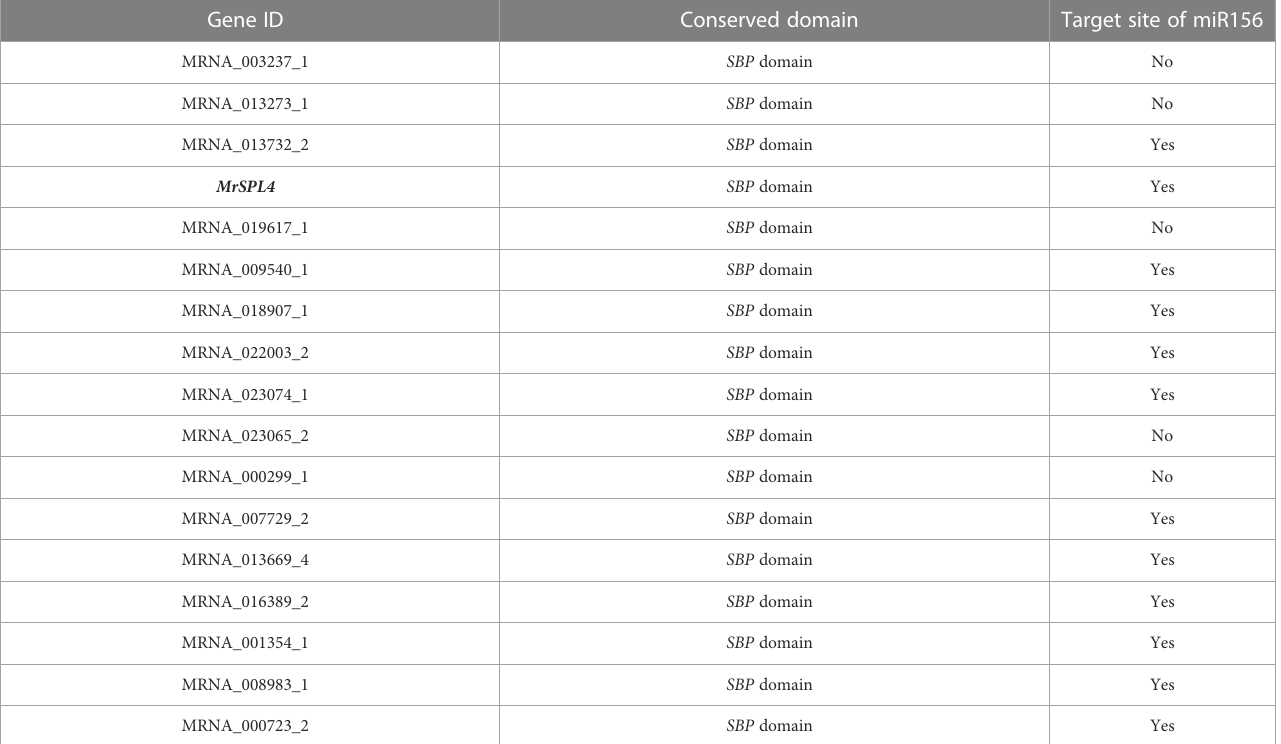
TABLE 3 Gene status of the SPL family in Myrica rubra genome. Gene ID Conserved domain Target site of miR156 SBP